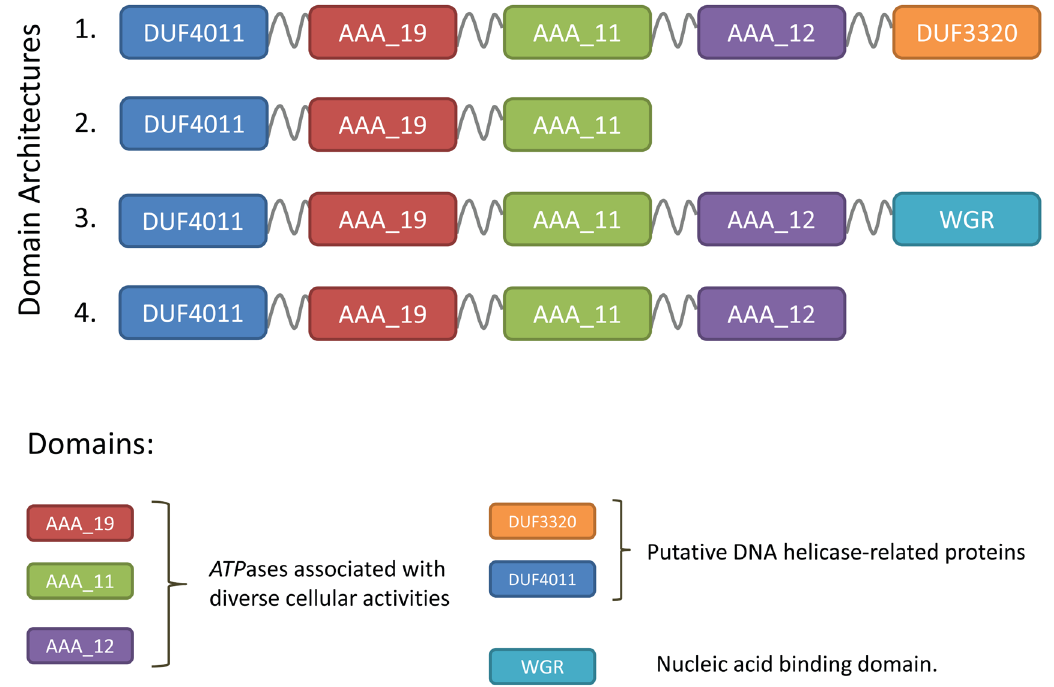
Figure 1. Domain architecture as a formal description of functional equivalence. Although the proteins obviously share a common core, four distinct domain architectures involving six protein domains were observed in (1) Enterobacteriaceae, (2) H. pylori, (3) Pseudomonas and (4)